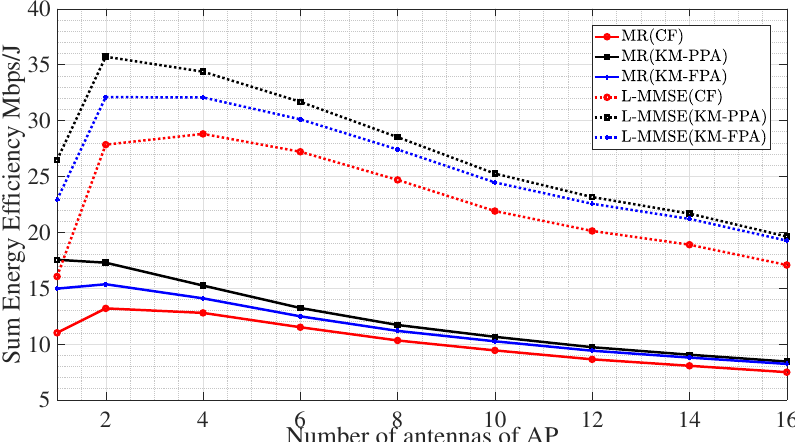
Figure 10. The sum energy efficiency versus the number of antennas.